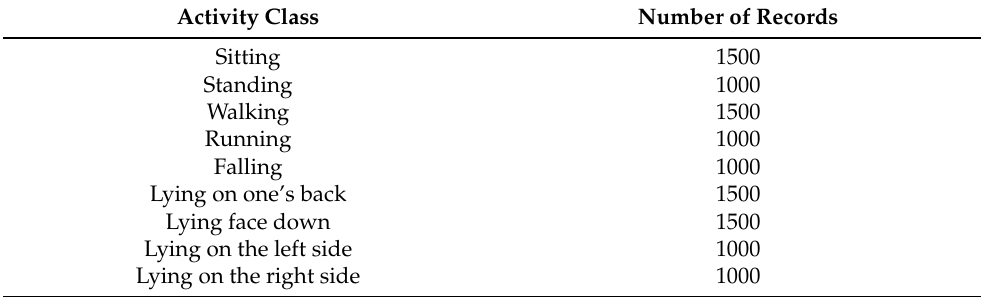
Table 1. The collected dataset.